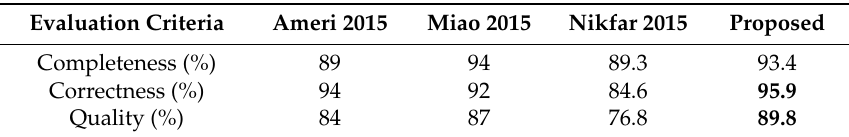
Table 3. Quantitative comparison of the proposed method with three other methods in the third study area.